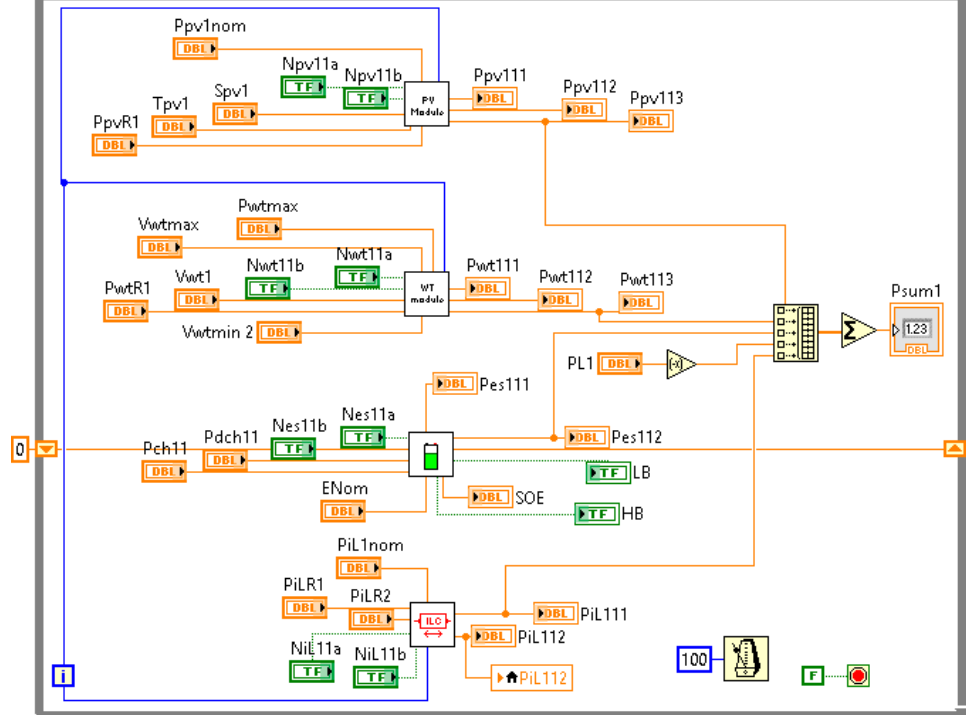
Figure 15. LabVIEW programming for DC bus 1.